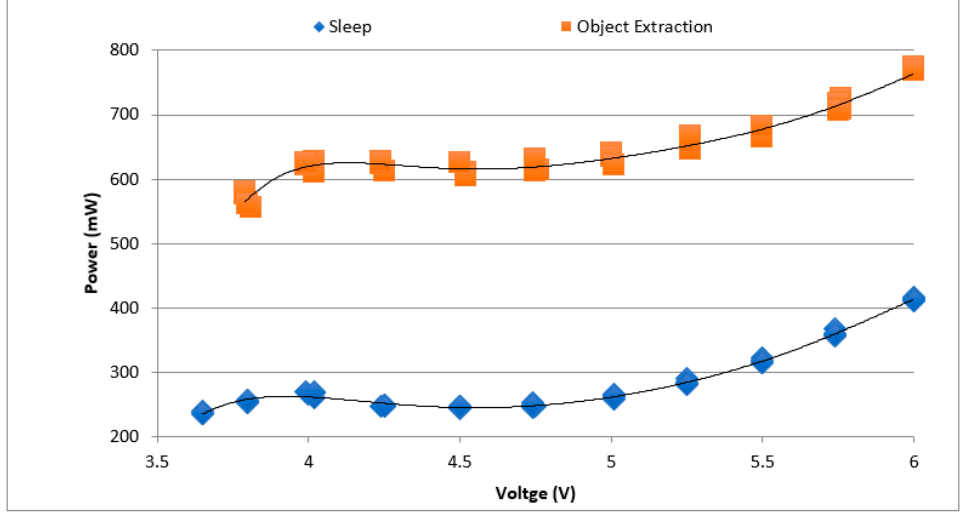
Figure 11. Power consumption profile of the sensor node for object extraction in data processing mode and sleep mode.